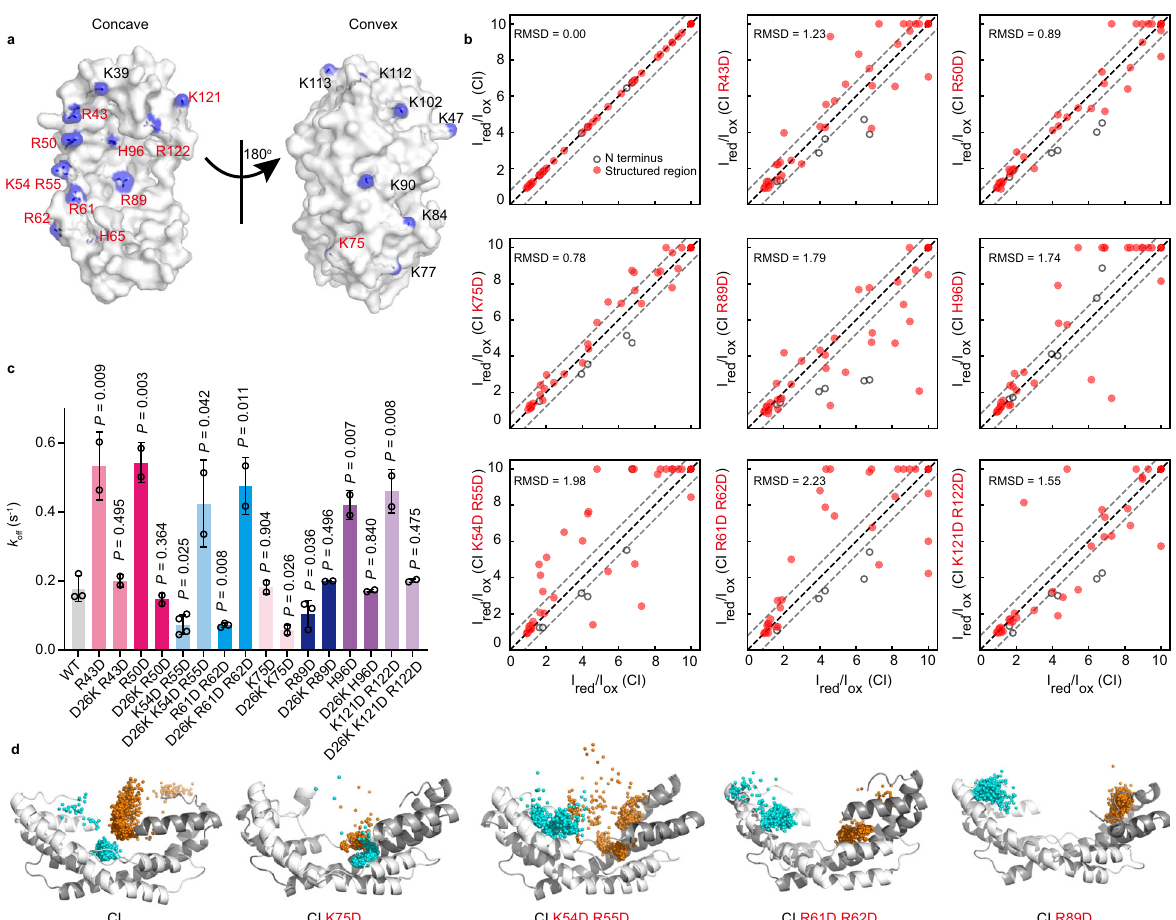
Fig. 4 The N-terminal residue D26 interacts with residues R89, K54, R55, R61, and R62 on the concave surface of Spy. a Surface representations of Spy 29-124 (PDB: 3O39) showing the side chains of all the positively charged residues in the stick model. The side chain nitrogen atoms of these residues are colored blue. Residues selected for further testing are labeled in red. b Correlations between the intramolecular PRE intensity ratios of different Spy 1-124 CI variants and the PRE signals of Spy 1-124 CI . The RMSD values of the PRE intensity ratios are presented for each comparison group. Gray dashed lines represent the deviation from the diagonal (black dashed line) for a value of 0.78, which is the RMSD value between Spy 1-124 CI and the control protein Spy 1-124 CI K75D . For the plot of Spy 1-124 CI and Spy 1-124 CI K75D , most of the data points are distributed between the two gray lines. Thus, these lines help to make a visual evaluation for the distribution of data points. c Comparisons of dissociation rate constants k off of Spy variants to the k off of Spy wild type (mean ± SD, n = 3 independent experiments for WT, R61D R62D, and R89D, n = 4 independent experiments for K54D R55D, n = 2 independent experiments for the other variants, individual data points are shown; unpaired two-tailed Student ’ s t test). Statistical analysis was performed with Graphpad Prism 9.1.0. d Position of the MTSL spin label on the concave surface of Spy during MD simulations of Spy CI and its variants. The two monomers of Spy are shown in white and gray, respectively. A total of 1000 frames are uniformly resampled in each 1- μ s trajectory, and the nitroxide oxygen (O1) atoms from each monomer are represented by cyan and orange spheres, respectively. Source data are provided as a Source Data fi